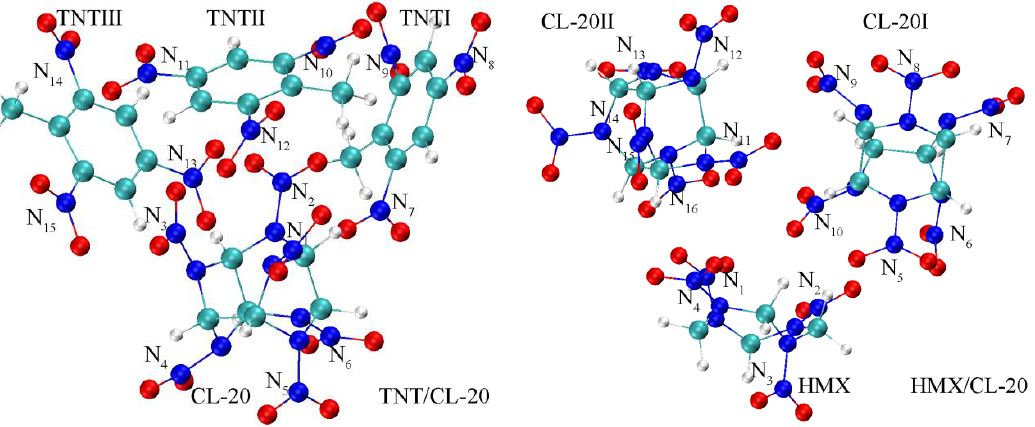
Figure 1. Optimized structures of TNT/CL-20 and HMX/CL-20. Carbon (C), oxygen (O), nitrogen (N), and hydrogen (H) atoms are represented by blue-green-, red-, blue- and white-colored balls, respectively. The nitrogen atoms in nitro groups are labeled by numbers.